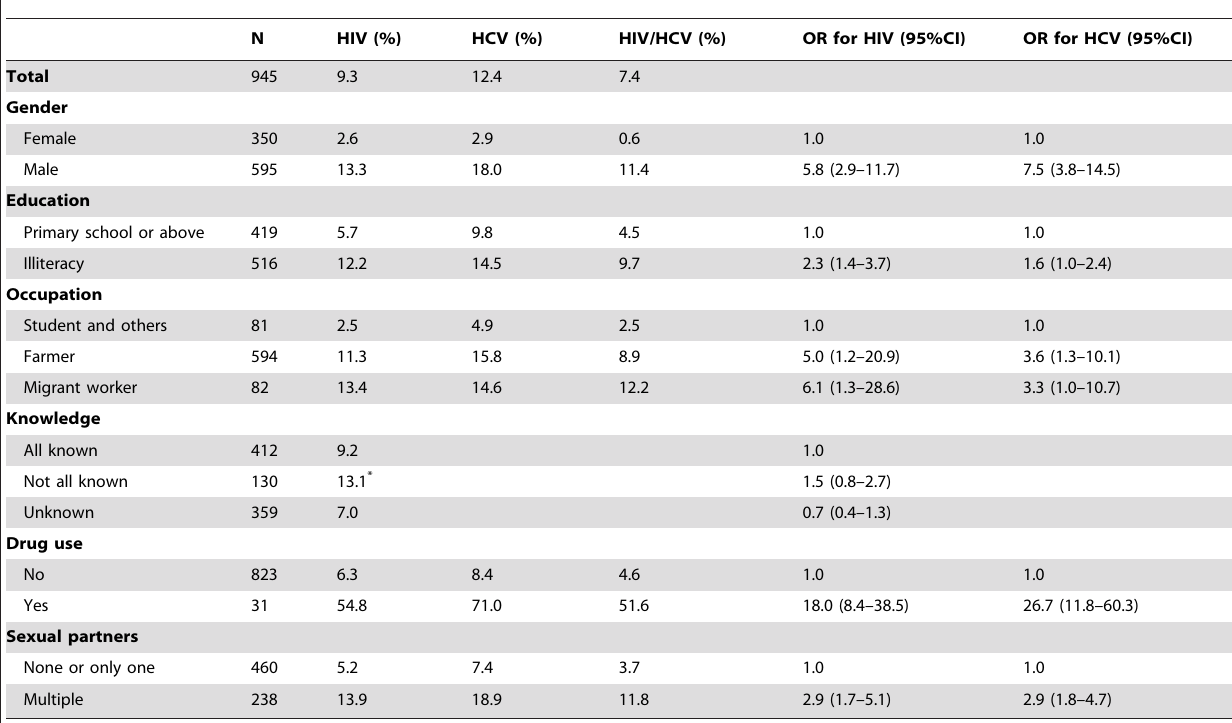
Table 4. Chi-square and logistic regression analysis of HIV and HCV prevalence among unmarried participants over the age of